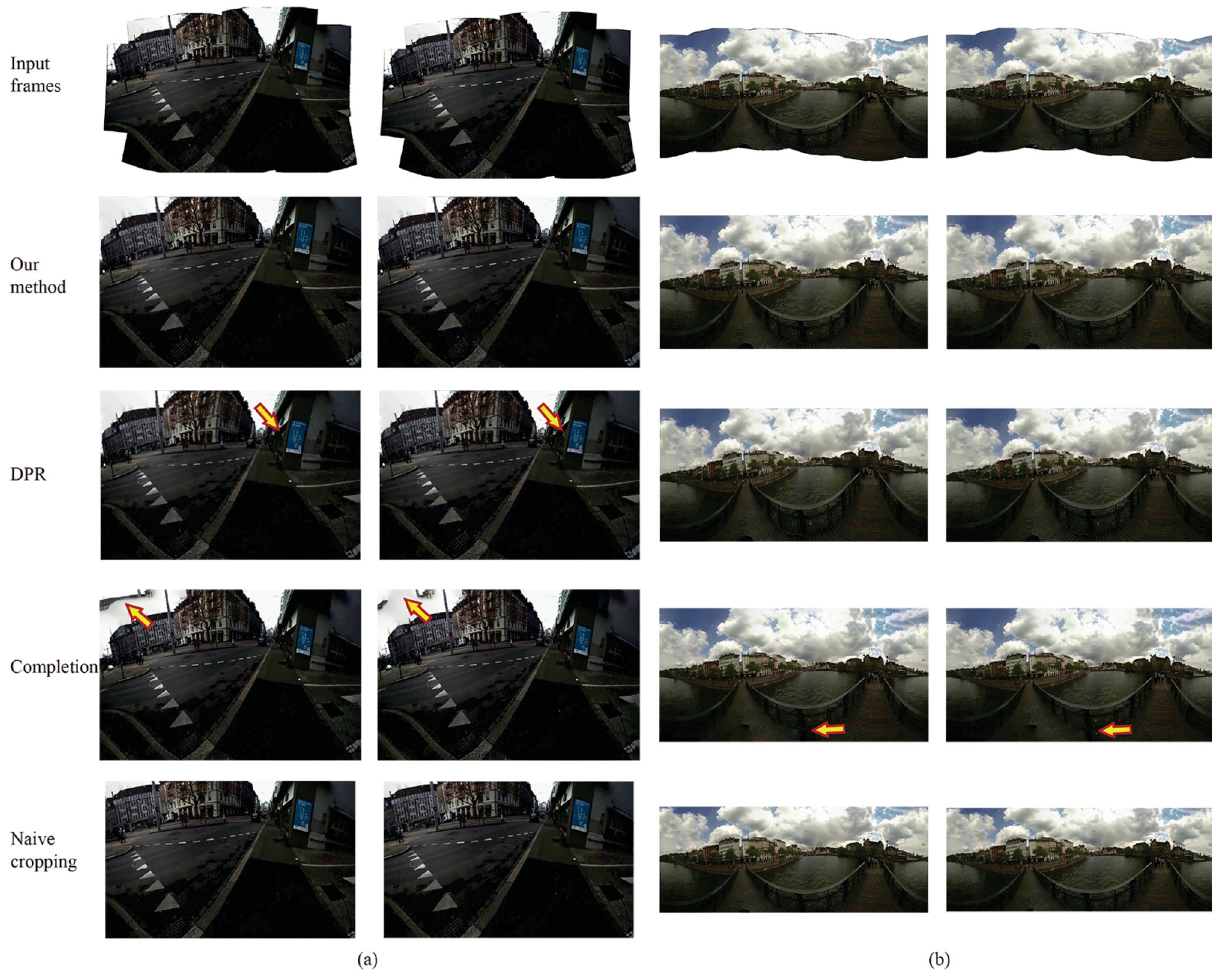
Fig. 7 Comparison of rectangling panoramic videos. Top to bottom: input frames of two examples; rectangling results using our approach, DPR [16], a video completion method [12], and naive cropping results.